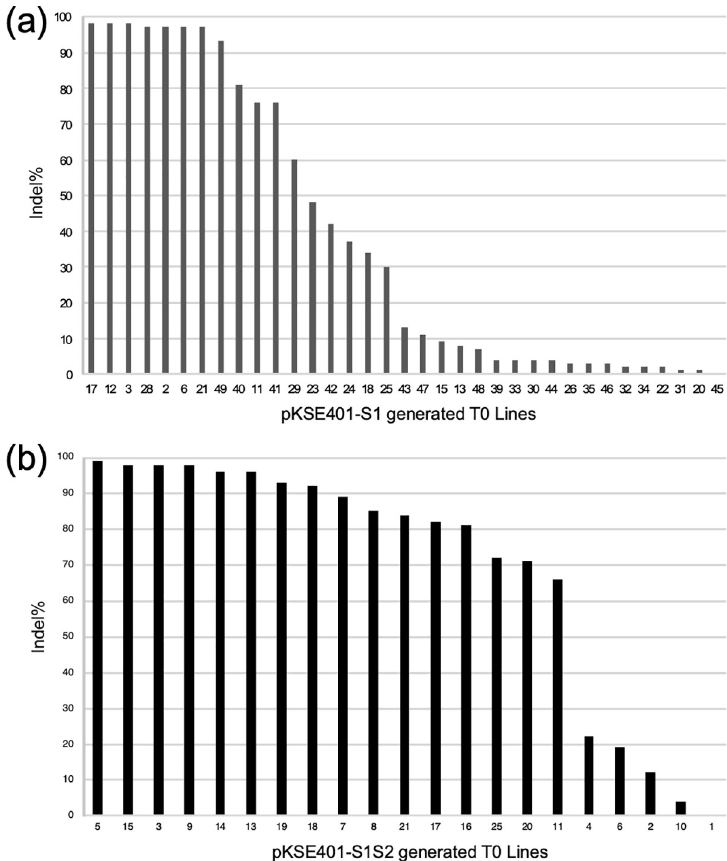
Fig 3. Indel percentages of T0 lines determined using interference of CRISPR edits v2 bioinformatic tool. (a) 35 lines transformed with pKSE401-S1. (b) 21 lines transformed using pKSE401-S1S2. Indel percentages of lines transformed with pKSE401-S1S2 consist of the mutations at both target sites.